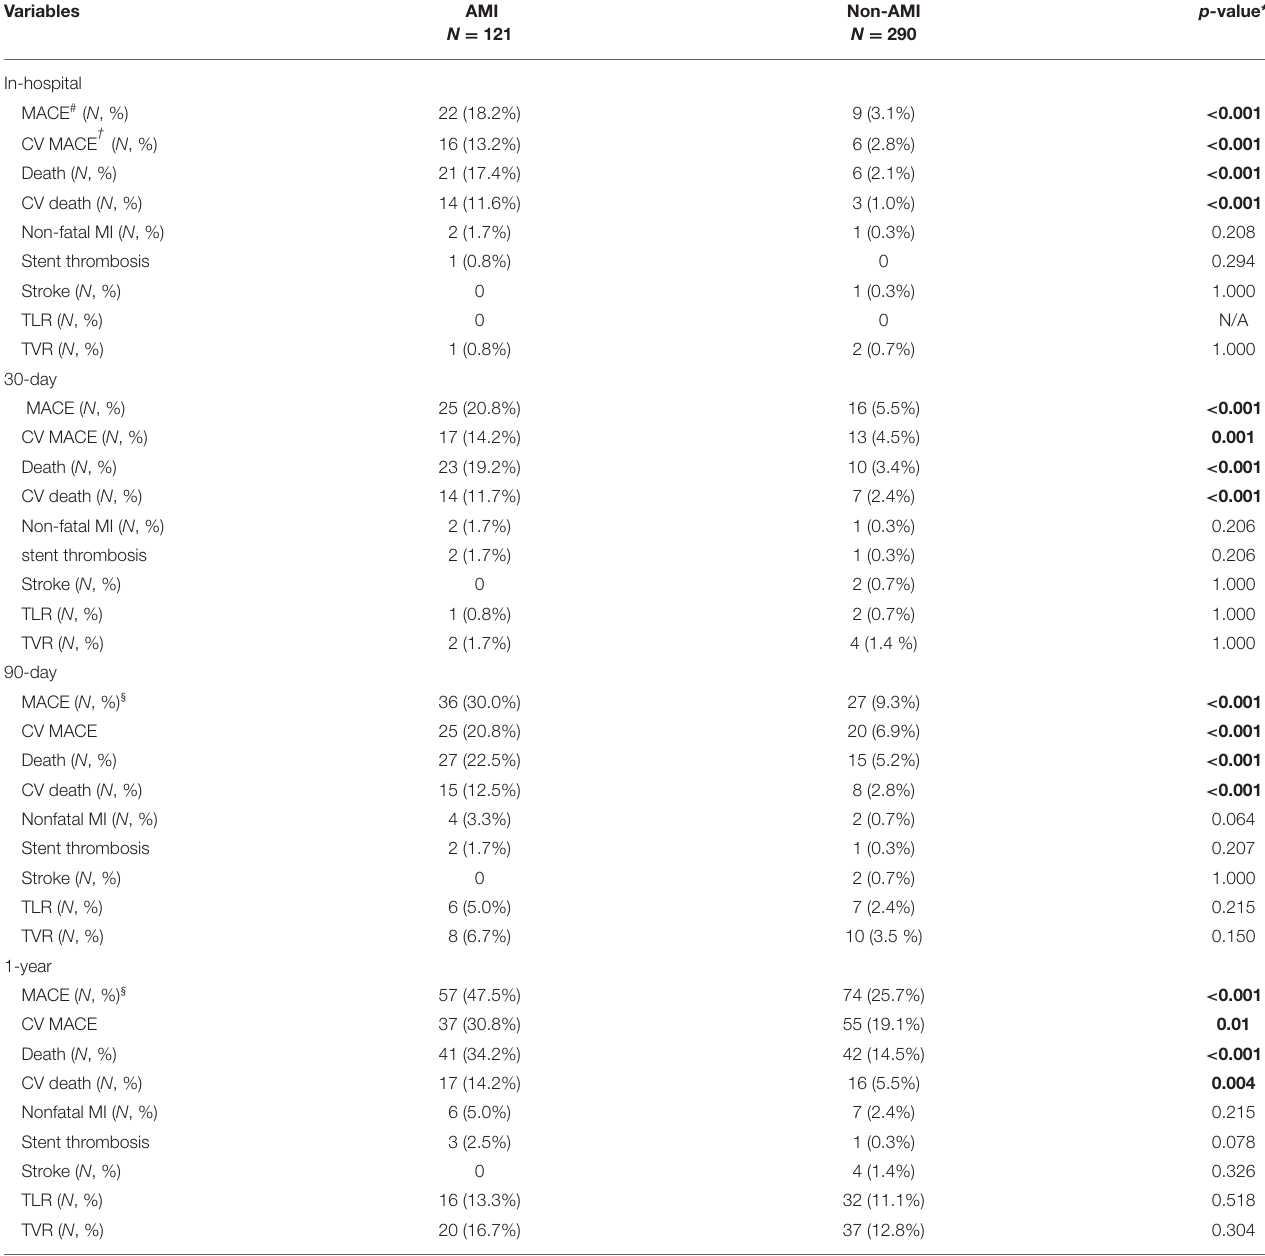
TABLE 4 | Clinical outcomes of rotational atherectomy in acute myocardial infarction (AMI) vs. non-AMI cases in the study period. Variables AMI